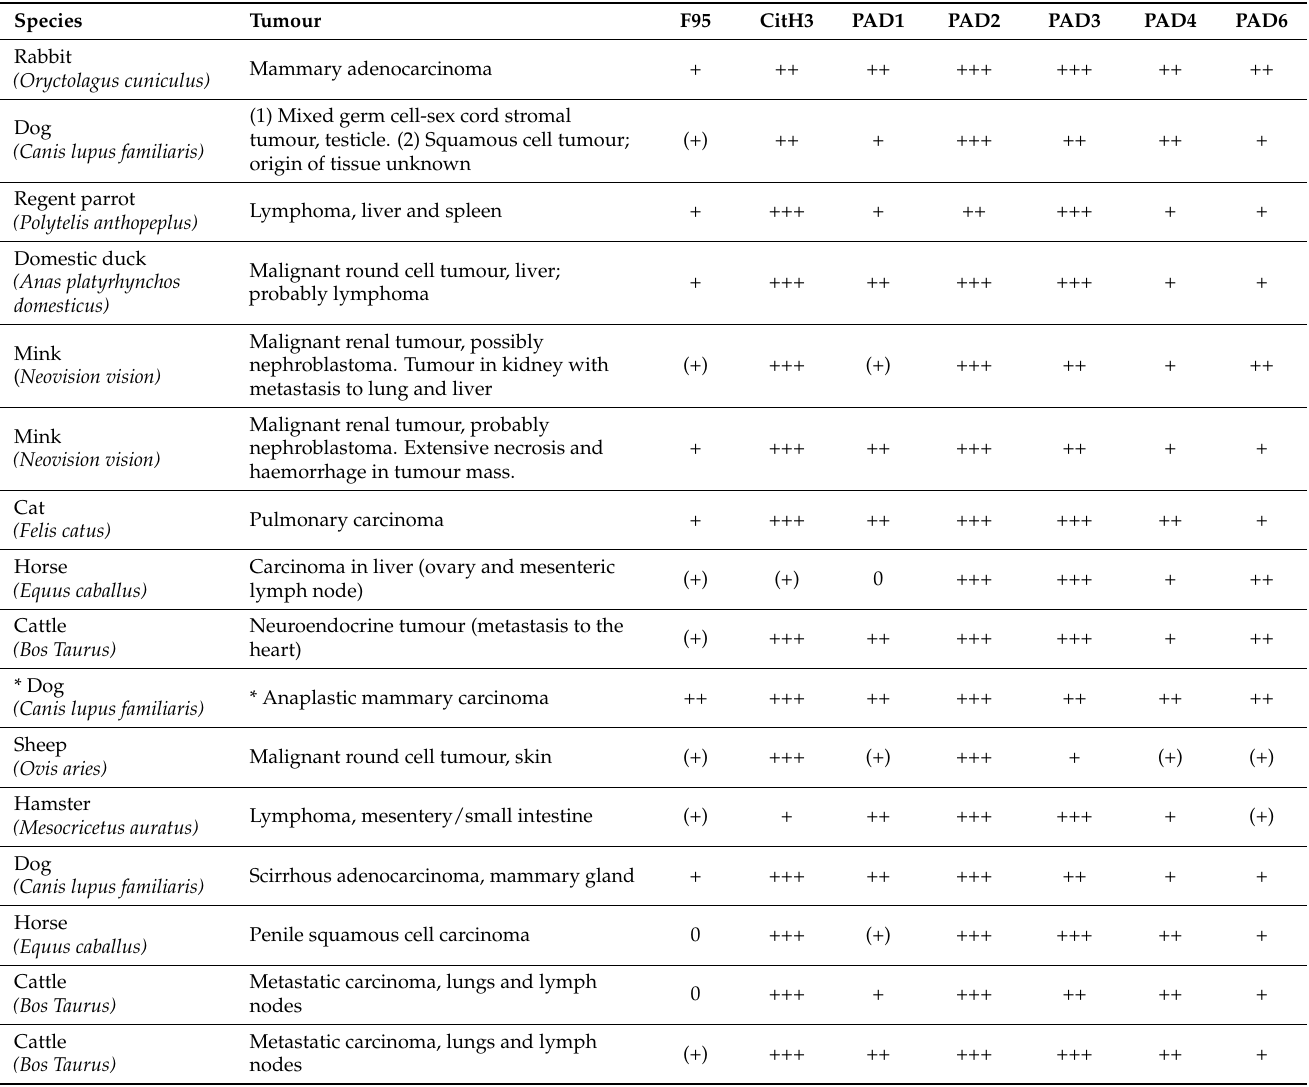
Neuroendocrine tumour (metastasis to the heart)